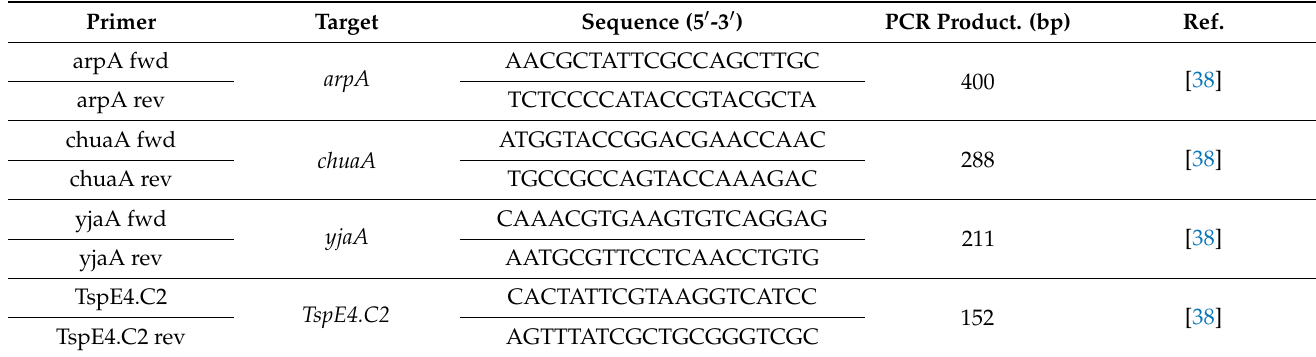
Table 7. List of primers used for the determination of phylogenetic groups.